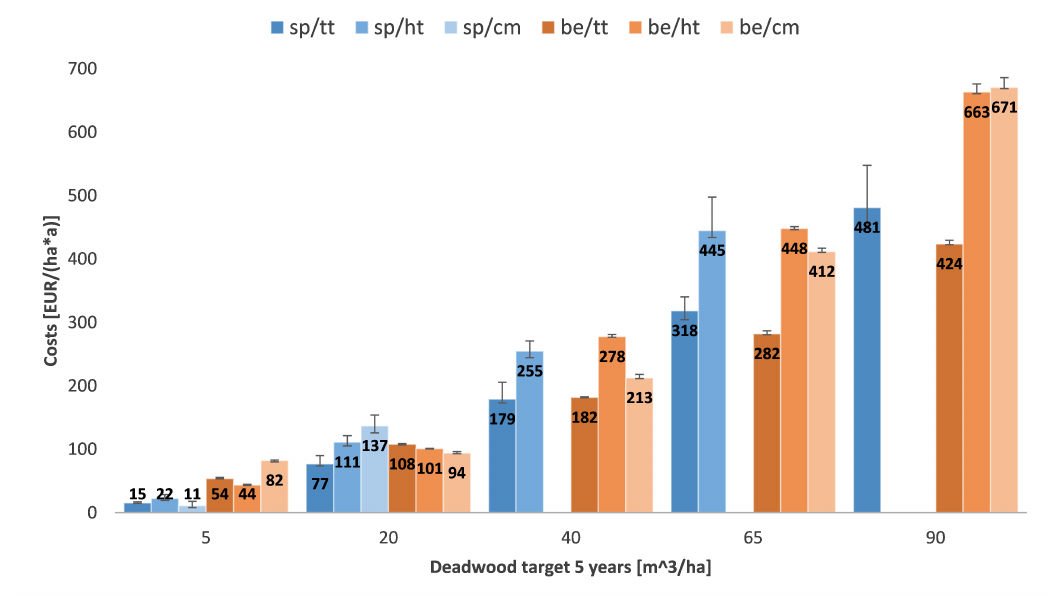
Figure 4. Forest enterprise “Neureichenau”: Costs in [ e ha − 1 a − 1 ] for target deadwood amounts in [m 3 ha − 1 ], to be maintained within 5 years. Blue columns show spruce ( sp ) and orange beech strategies ( be ). tt : Total tree, ht : Heavy timber, cm : Crown material.